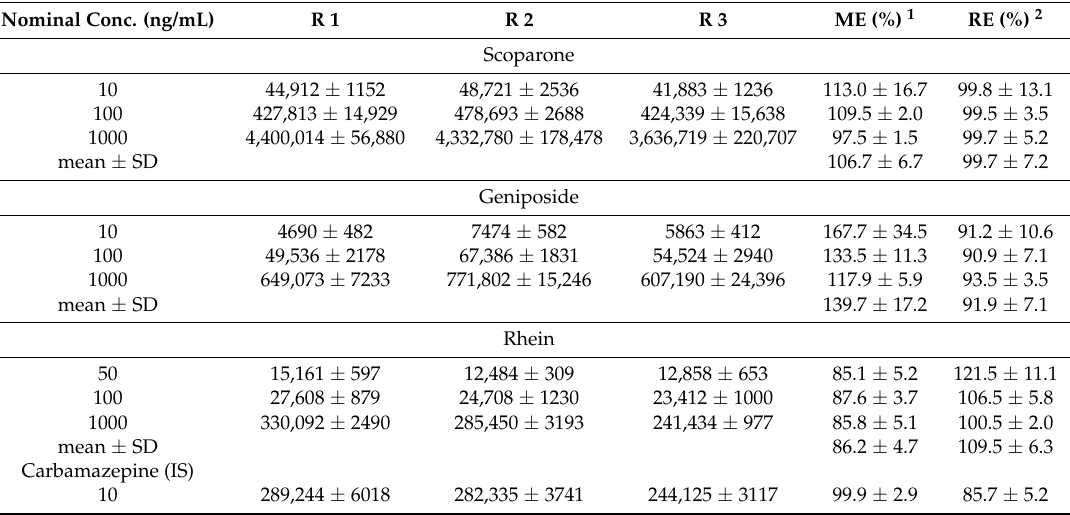
Table 4. Extraction recovery and matrix effect of the marker